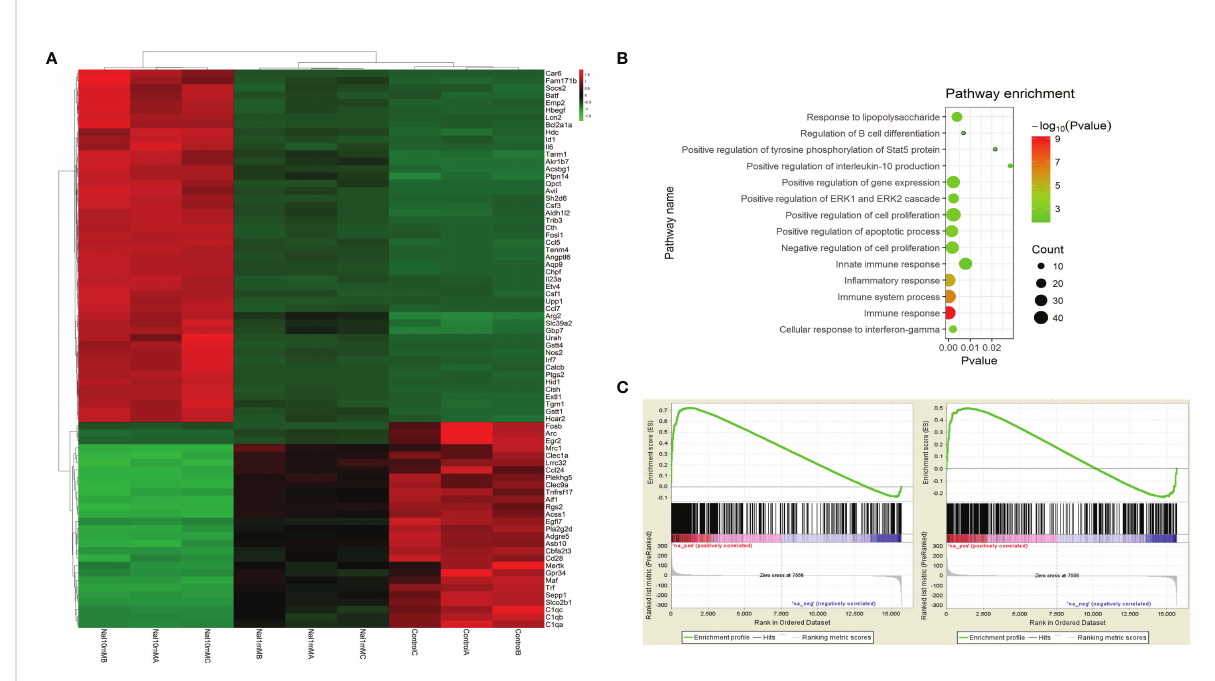
FIGURE 4 mRNA-seq of RAW264.7 cells stimulated by high iodine. (A) Differences in the mRNA transcriptome of various groups (NaI of 0 mM, 1mM and 10mM); (B) GO analysis; (C) GSEA of macrophage polarization in transcriptome of RAW264.7 cells stimulated by 10 mM of NaI (From left to right: M1 and M2).